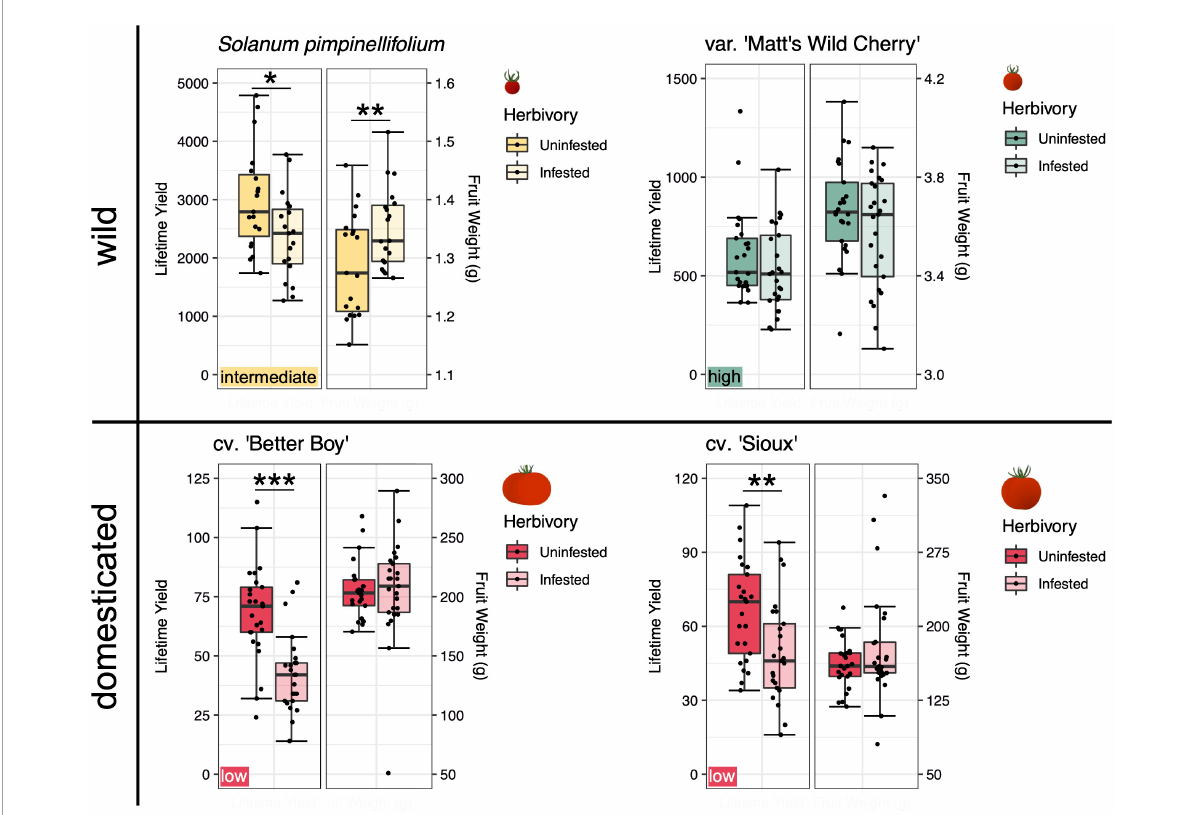
FIGURE1 Lifetime yield and single fruit weight of individual plants from wild and domesticated tomato lines, separated by herbivory treatment (tobacco hornworm infested or uninfested). Yield and fruit weight from truncated, but not full, lifespan groups are shown. The left-hand y -axis depicts fruit yield, while the right-hand y -axis depicts fruit weight. Note the changing y-axes across panels due to variation in yield and fruit weight across tomato lines. Each line is represented by n = 25 blocks, except for S. pimpinellifolium , which is represented by n = 19 blocks. Significant differences in yield between herbivory treatments are indicated (see Supplementary Table 2 ): * represents p < 0.05, ** represents p < 0.01, and *** represents p < 0.001. Tolerance categories for each line are included in panel